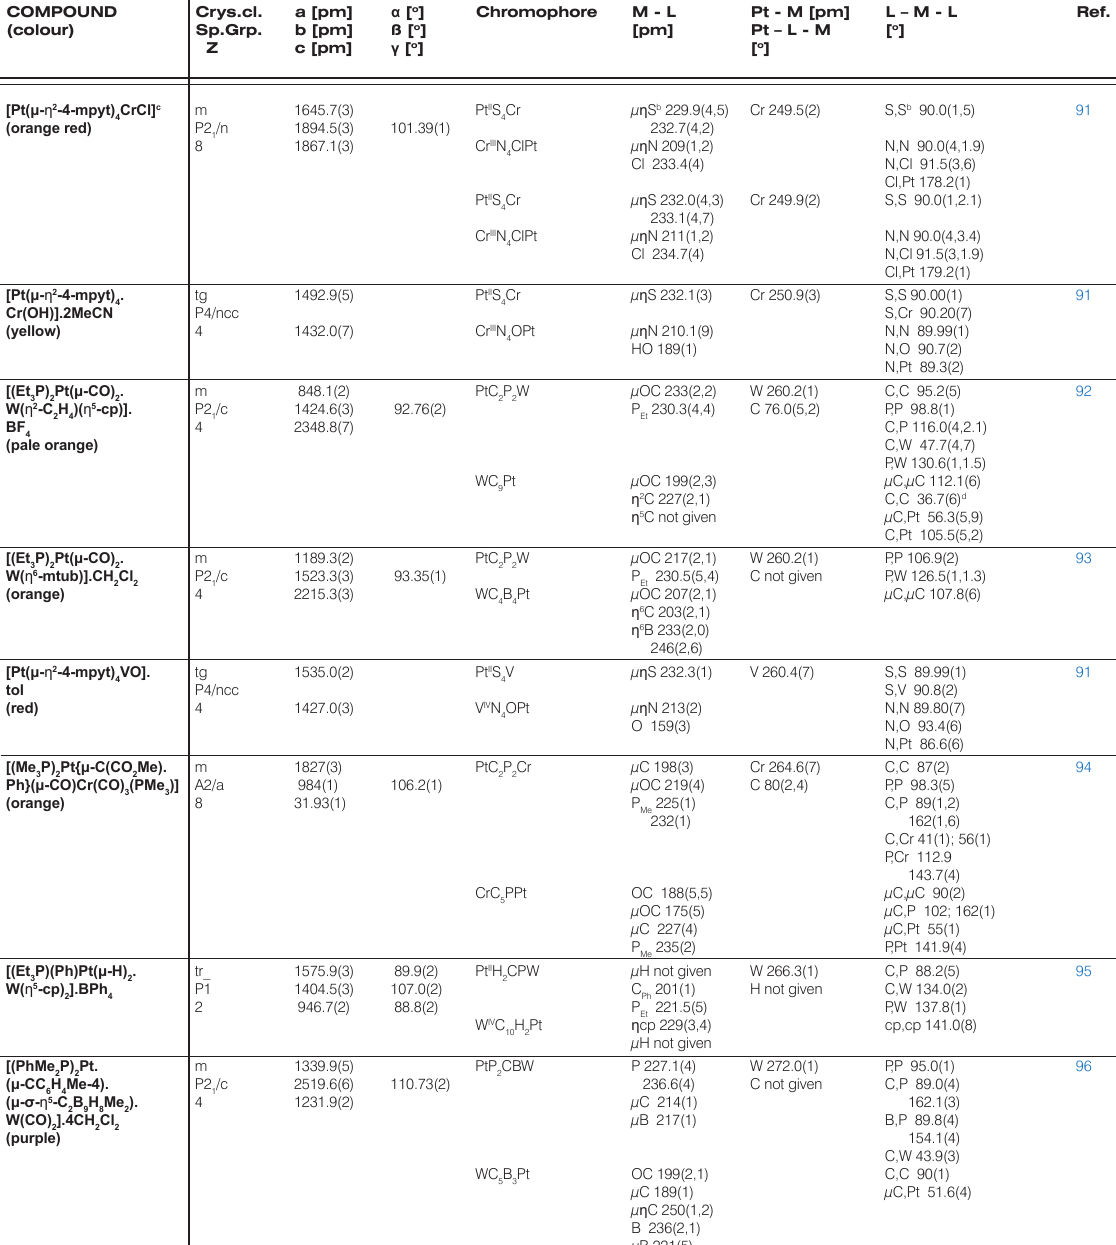
distortion isomerism [76]. The latter example [93] also There are three examples which contain two contains chemically in equivalent molecules, with 40% of crystallographically independent molecules differing molecule (1) and 30% each of molecules (2) and (3). The mostly by degree of distortion of the M-M, M-L and molecules (2) and (3) are disordered. L-M-L parameters; Pt(μ-η 2 -4-mpyt) CrCl] [91 ], [(η 4 -C H ) 4 8 12 Table 3. Heterobinuclear Platinum Compounds with Pt-M Bond (M = Ti, V, Ta, Cr, Mo or W) a COMPOUND Crys.cl. (colour)